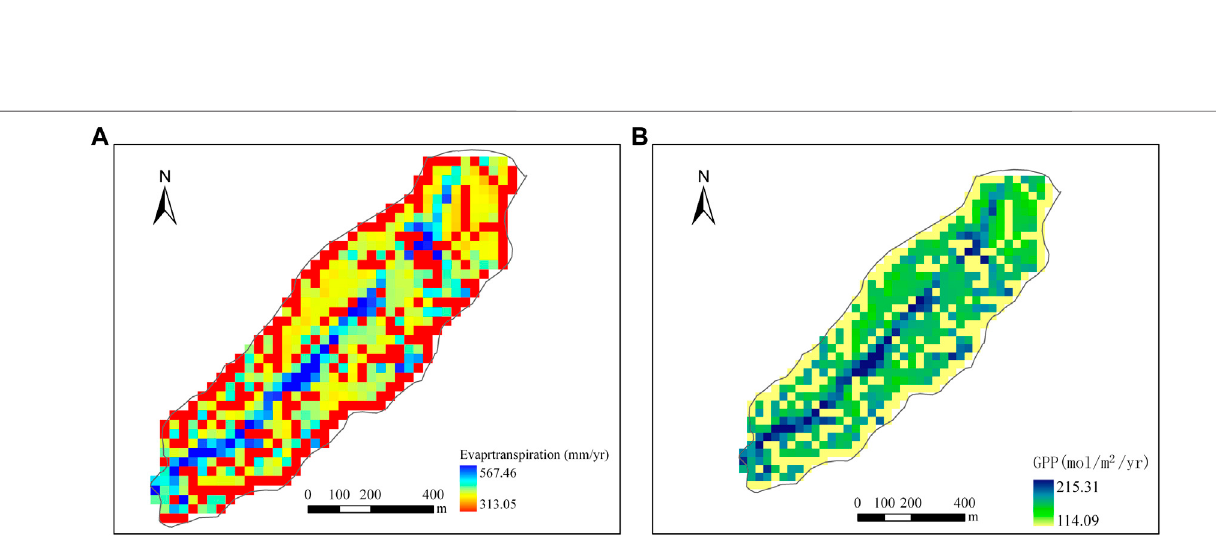
Frontiers in Environmental Science |